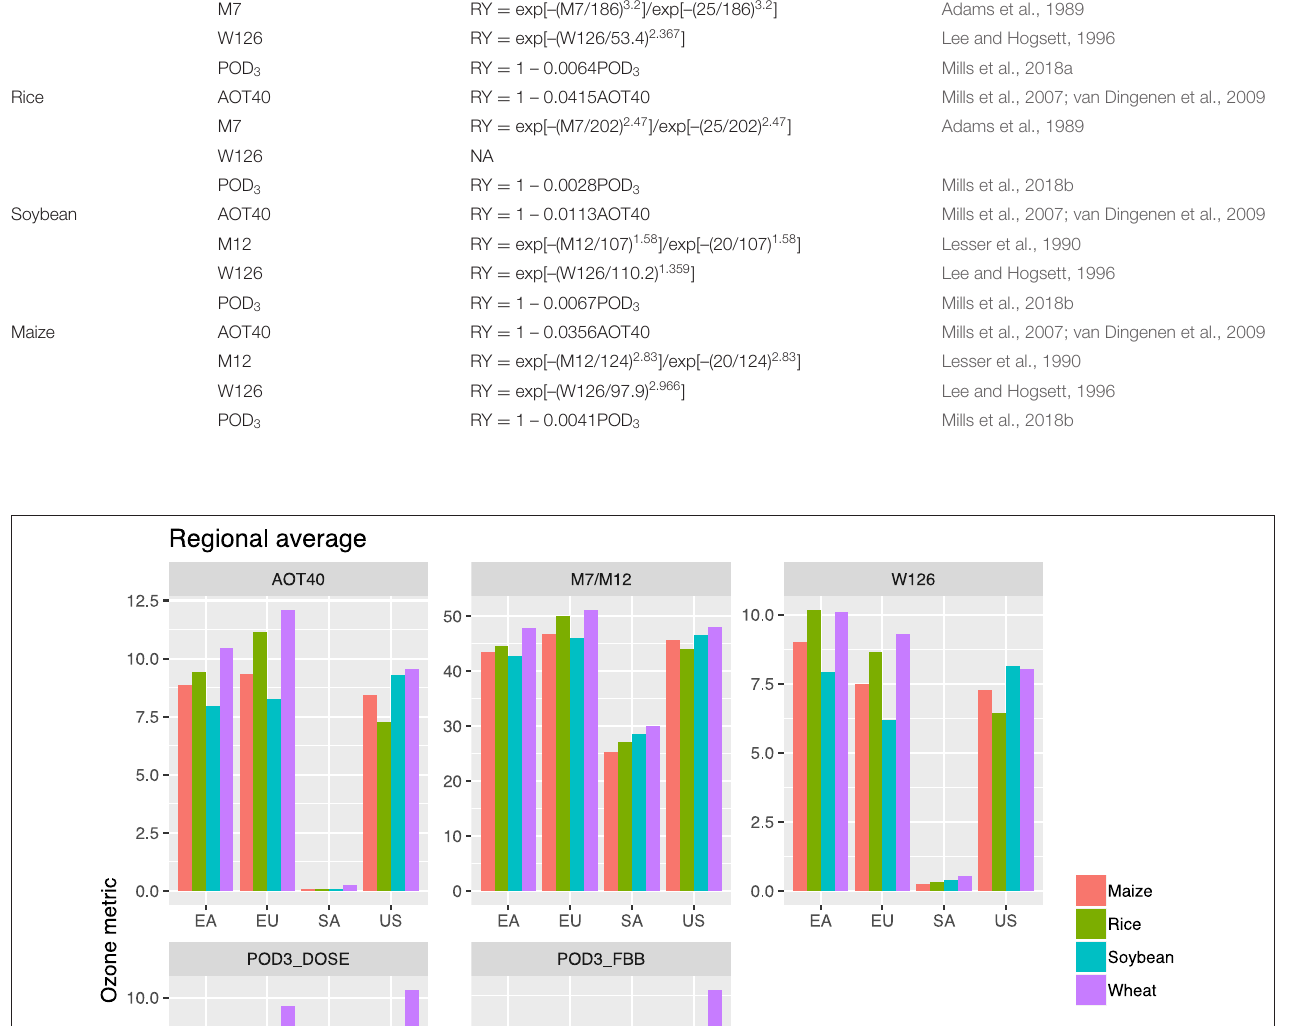
Frontiers in Sustainable Food Systems |